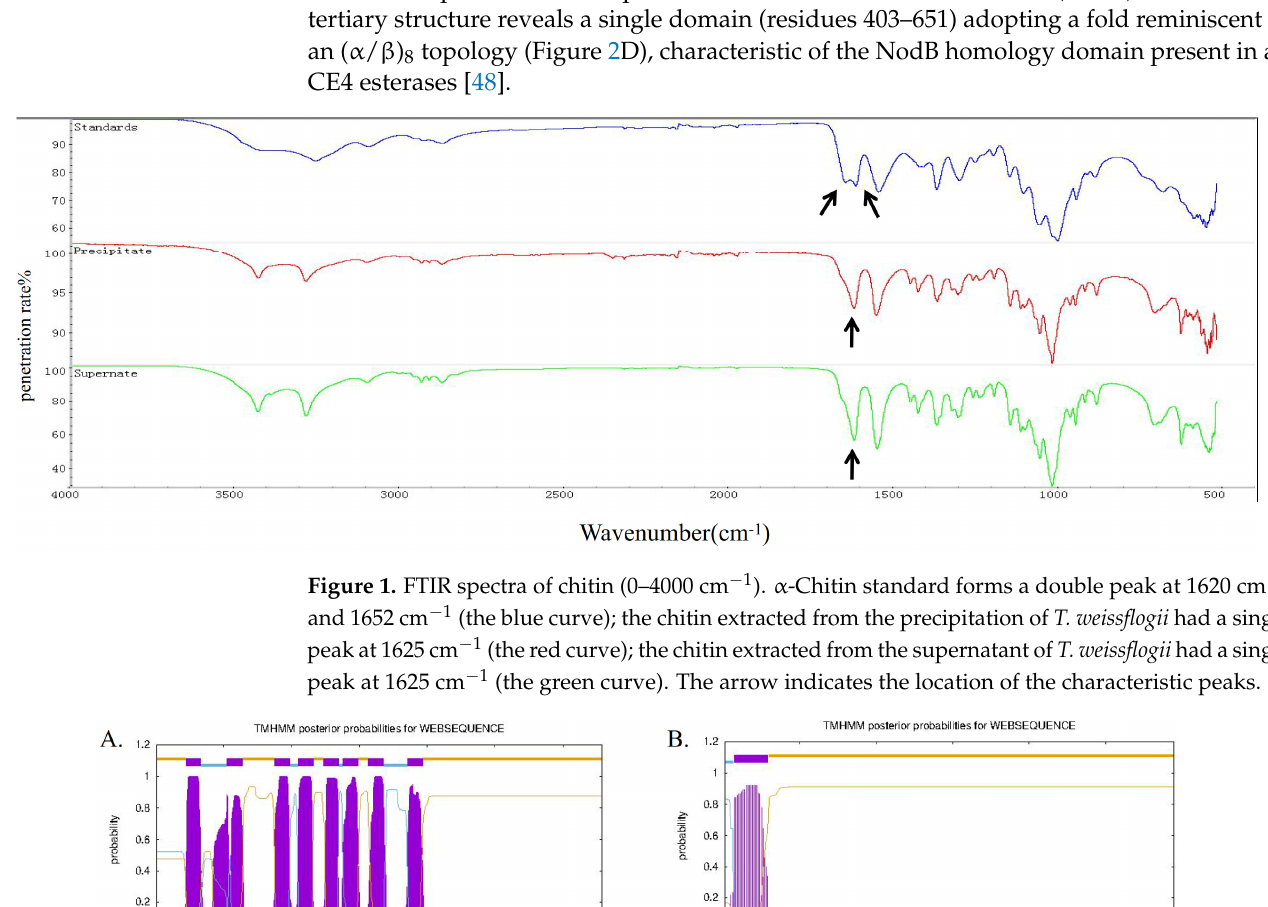
Figure 2. Sequence comparison between TwCDA and TwCDA-S. ( A ) TwCDA has 8 transmembrane helices at amino acids 44 to 393 and a signal anchor. ( B ) TwCDA-S has 1 transmembrane helix at